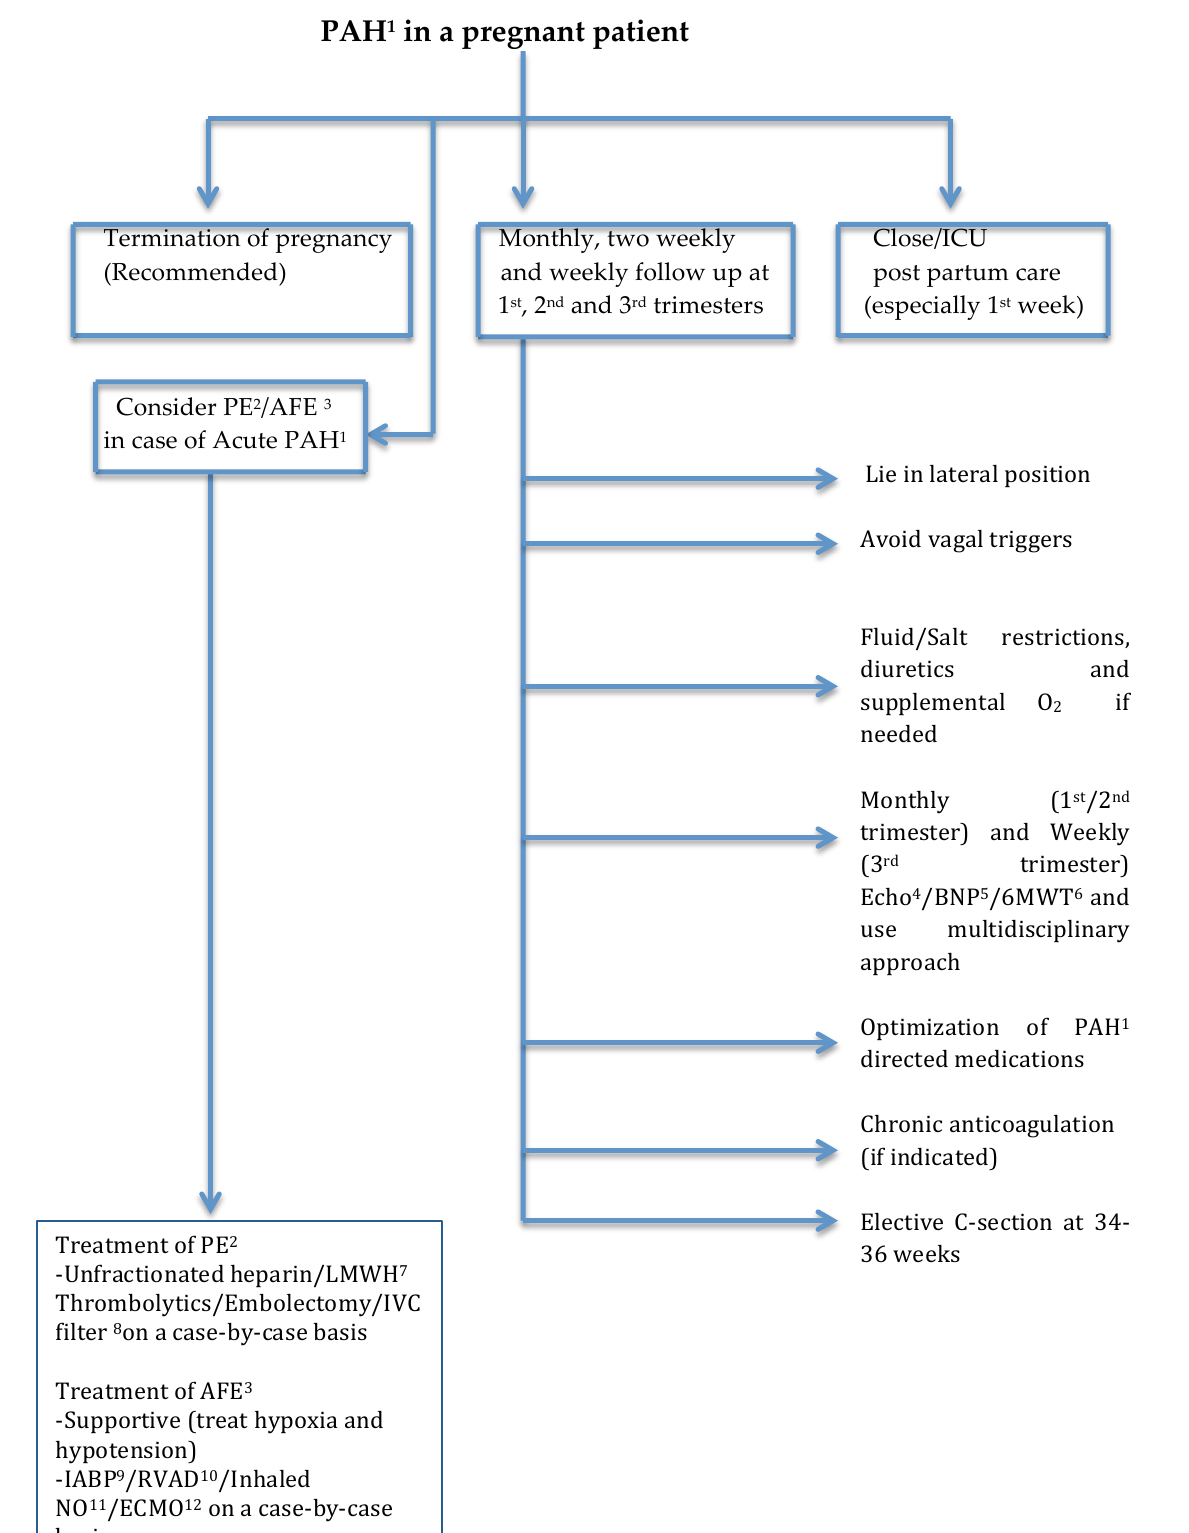
Figure 2. General scheme for management of PAH in a pregnant patient. 1 PAH = Pulmonary arterial hypertension, 2 PE = Pulmonary embolism, 3 AFE = Amniotic fluid embolism, 4 Echo = Echocardiogram, 5 BNP = Brain natriuretic